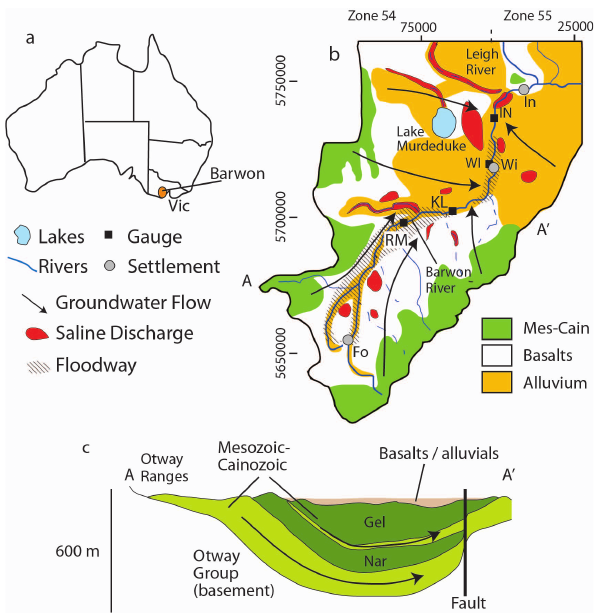
Fig. 1. (a) Location of upper Barwon catchment in Aus- tralia (Vic=Victoria). (b) Hydrology of the upper Barwon catchment showing simplified geology (Mes-Cain=Mesozoic– Cainozoic sediments), groundwater flow directions, location of gauges (IN=Inverleigh; KL=Kildean Lane; RM=Ricketts Marsh; WI=Winchelsea), saline discharge sites, and settlements (Fo=Forrest; In=Inverleigh; Wi=Winchelsea). (c) Section across the upper Barwon catchment – A–A 0 in (a) – showing the broad geological structure. Mesozoic–Cainozoic aquifers shown in light green, aquitards (Gel=Gellibrand Marl; Nar=Narrawatuk Marl) in dark green. Data from Witebsky et al. (1995), Corangamite Catch- ment Management Authority (2005), and Water Resources Data Warehouse